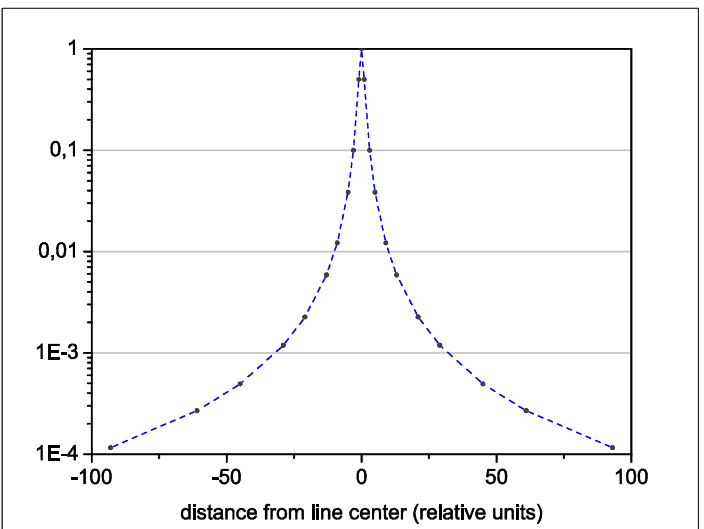
Figure 3. Illustration of the effective interpolation technique using the nonuniform wavenumber grid for the line profile